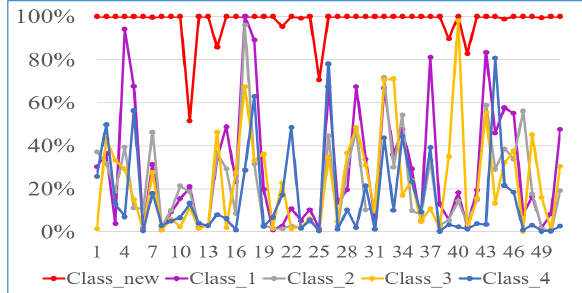
Figure 4. The classification results of the target in TB50. The vertical axis is the percentage that the target classified as different class in all 51 tracking sequence.